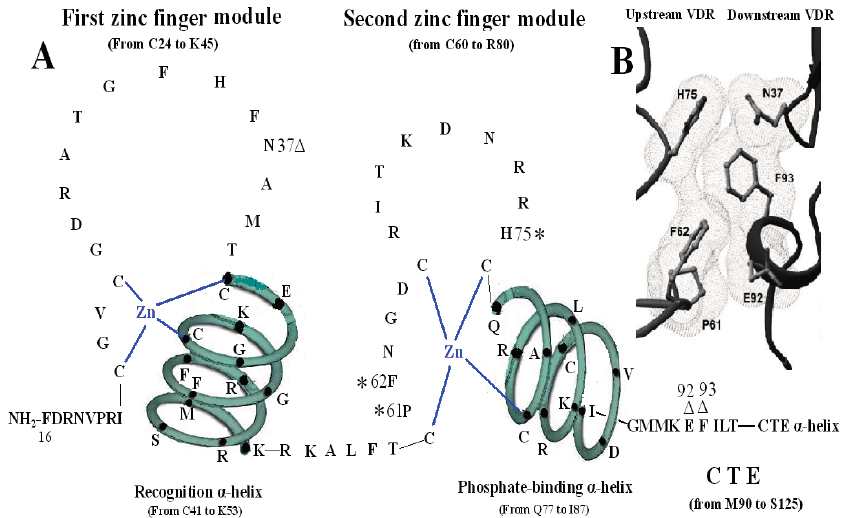
Figure 3. Homodimerization interface of VDR DBD. ( A ) The amino acids forming VDR homodimerization interface. 3 asterisks of H75, P61 and F62 form upstream dimmer interface and three triangles of N37, E92 and F93 form downstream dimmer interface. ( B ) Stereo view of the VDR homodimerization interface in a van der Waals surface representation. Figure 3B adapted from Shaffer and Gewirth